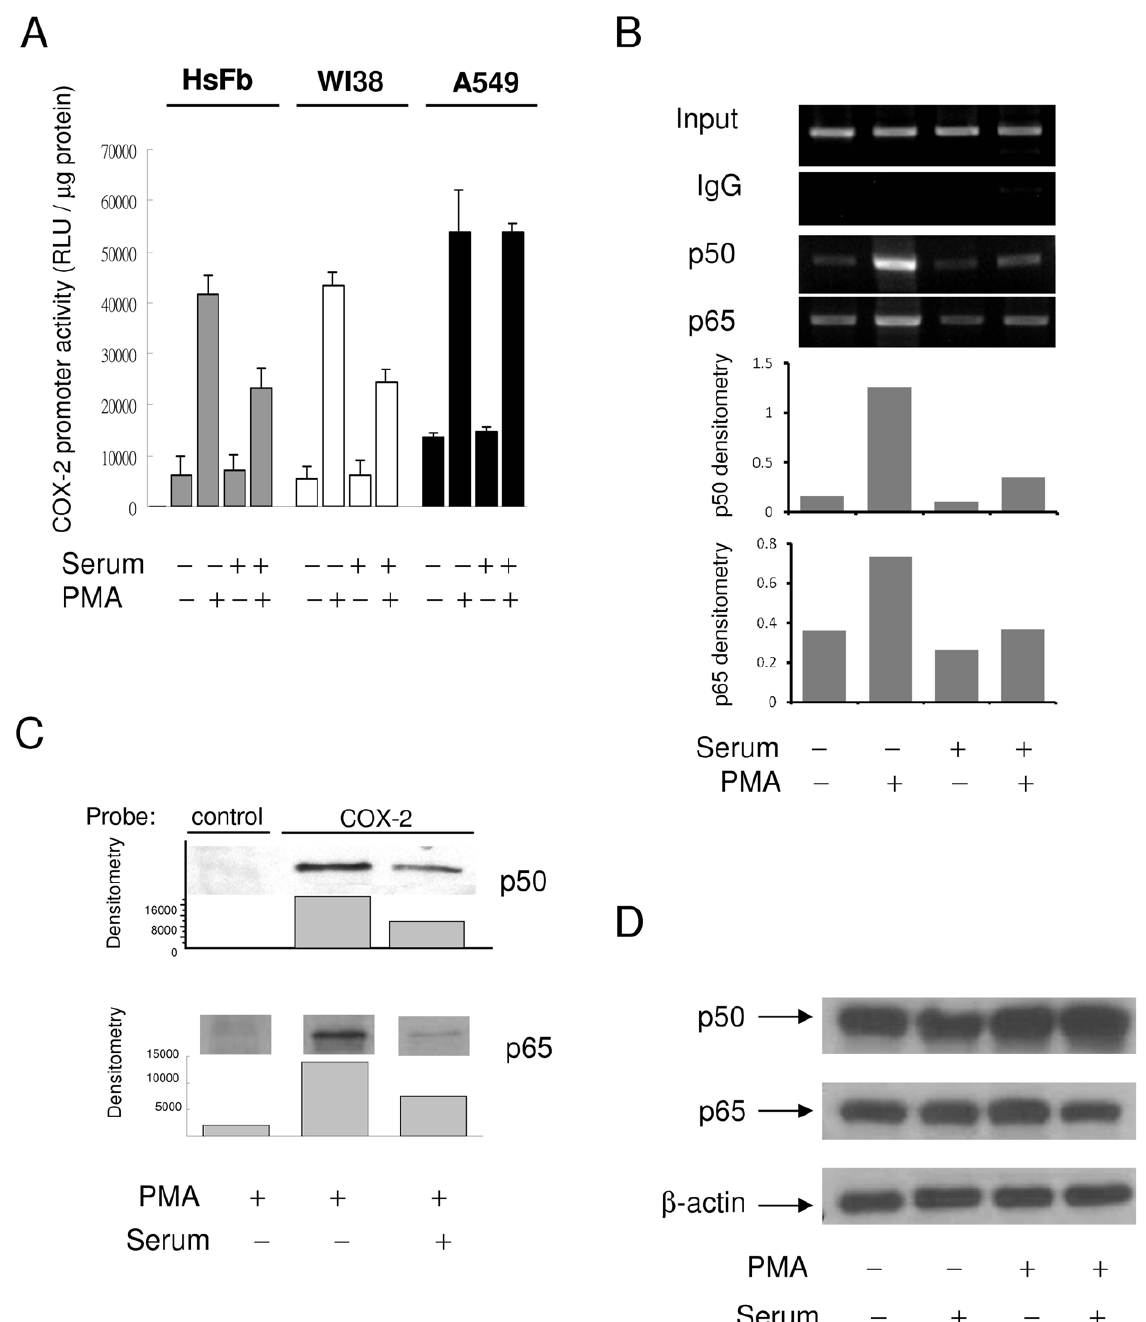
Figure 5. Differential COX-2 transcriptional activation in SF- vs. SR-cells. ( A ) COX-2 promoter activity in SF vs. SR HsFb, WI38 and A549 cells. Each bar denotes mean 6 SEM (n=3). ( B ) and ( C ) NF- k B (p50/p65) binding to COX-2 promoter region analyzed by ( B ) ChIP and ( C ) streptavidin pulldown assay. ( D ) p50 and p65 NF- k B protein levels in SF- vs. SR-HsFb treated with and without PMA.